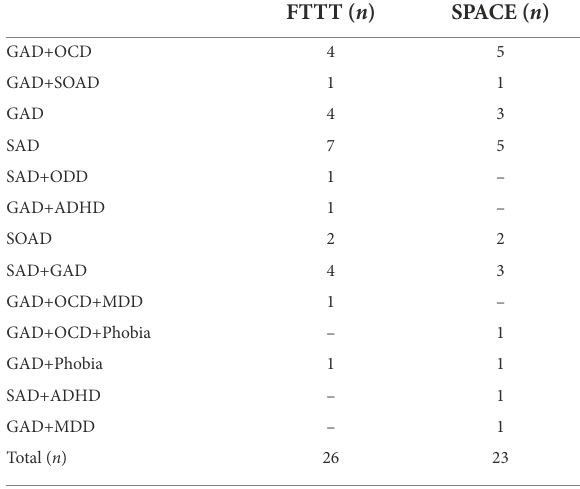
TABLE 1 The psychiatric diagnoses of children in the intervention groups based on diagnostic criteria of DSM 4-TR. FTTT ( n